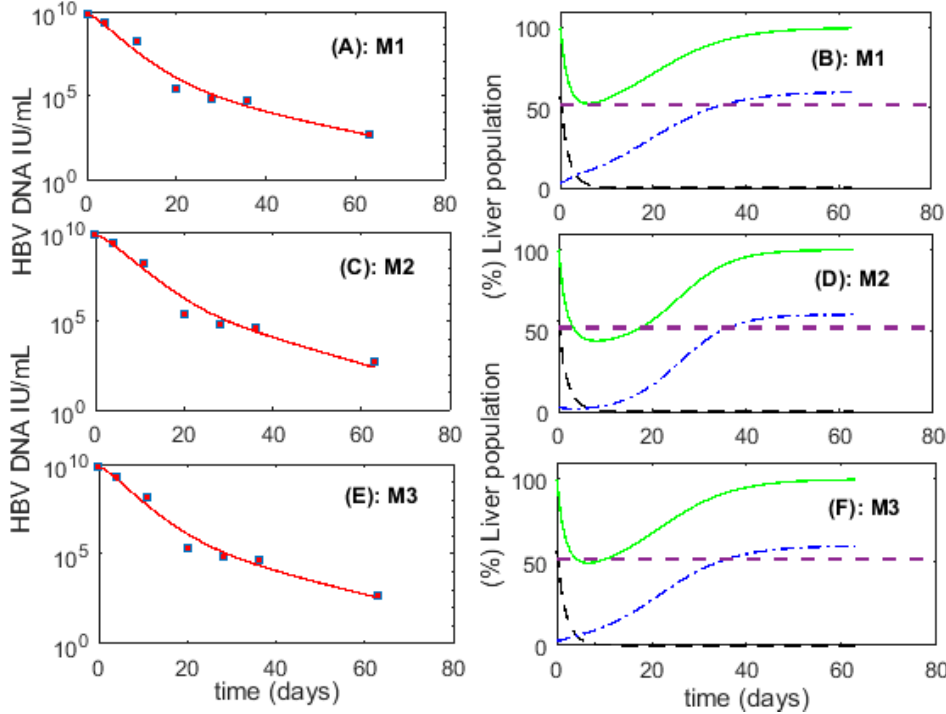
Figure 1. Panels ( A ), ( C ) and ( E ) represent the best fit (line) to hepatitis B virus (HBV) viremia data (squares) for patient 1 using M1 , M2 and M3 respectively; panels ( B ), ( D ) and ( F ) represent (%) infected cell population ( I , black dashed line), (%) uninfected cell population ( T , blue dashed dot line), and (%) total liver cell population (100 ( I + T + θ H ) / H , green solid line) corresponding to the best fit of HBV viremia data. The dotted horizontal line represents the critical threshold for the liver cell population during the process of infection clearance (0.52 H ). Best-fit parameter values are given in Table S7.